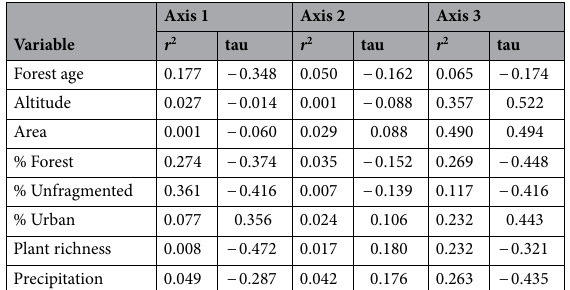
Table 2. All Pearson r 2 , and Kendall (tau) correlation coefficients between environmental variables and the three-dimensional NMDS configuration of sampling units in species space. For definitions of environmental variables, see Supplementary Table S2.